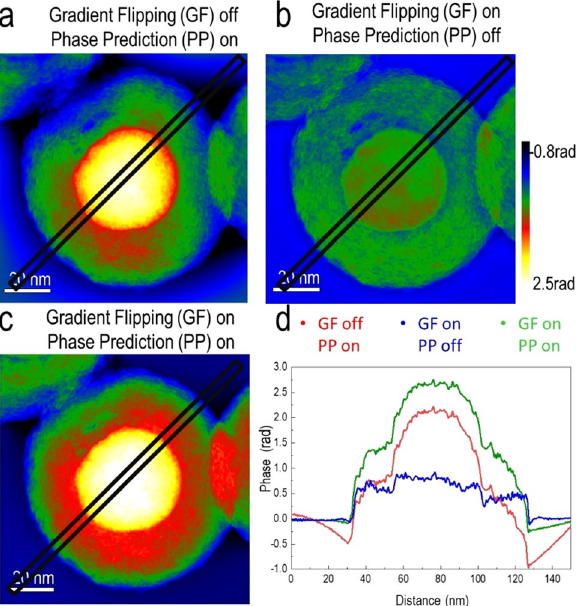
Figure 4. Comparison between individual and combined effects of gradient flipping and phase prediction. ( a ) Phase reconstruction with gradient flipping (GF) off and phase prediction (PP) on. ( b ) Phase reconstruction with GF on and PP off. ( c ) Phase reconstruction with GF on and PP on. ( d ) Line profiles extracted along the lines marked in the phase